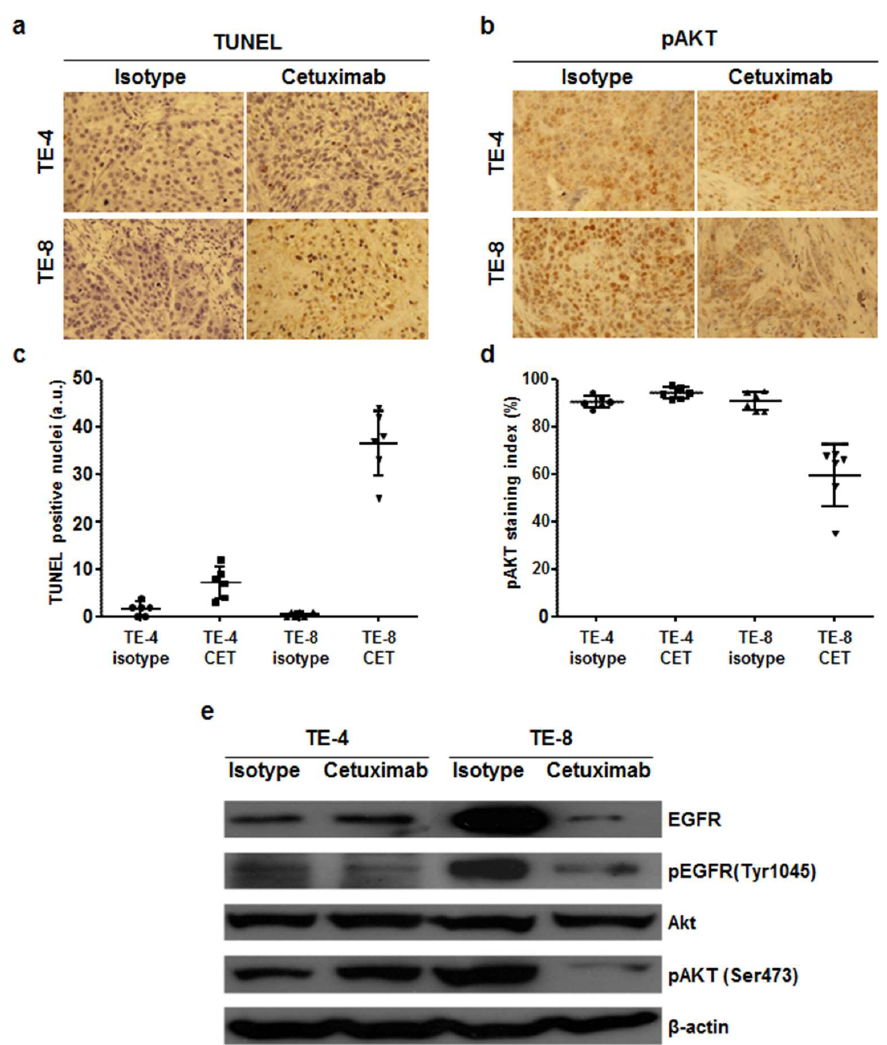
Figure 7. Immunohistochemial staining of TUNEL and phospho-Akt and western blot analysis of TE-4 and TE-8 tumors with isotype or cetuximab treatment. Apoptotic nuclei and phospho-Akt immunoreactivity are shown in brown. ( a ) TUNEL positive nuclei significantly increased in TE-8 tumor with cetuximab treatment. ( b ) pAkt immunoreactivity markedly decreased in cetuximab-treated TE-8 tumor. Representative images were taken under × 400 magnification. ( c ) and ( d ) TUNEL positive nuclei ( c ) and pAkt staining index ( d ) were quantified. ( e ) Western blot analysis of EGFR expression level and its downstream targets in TE-4 and TE-8 tumor. EGFR and pAkt level in TE-8 tumor markedly decreased with cetuximab treatment, but they were maintained in TE-4